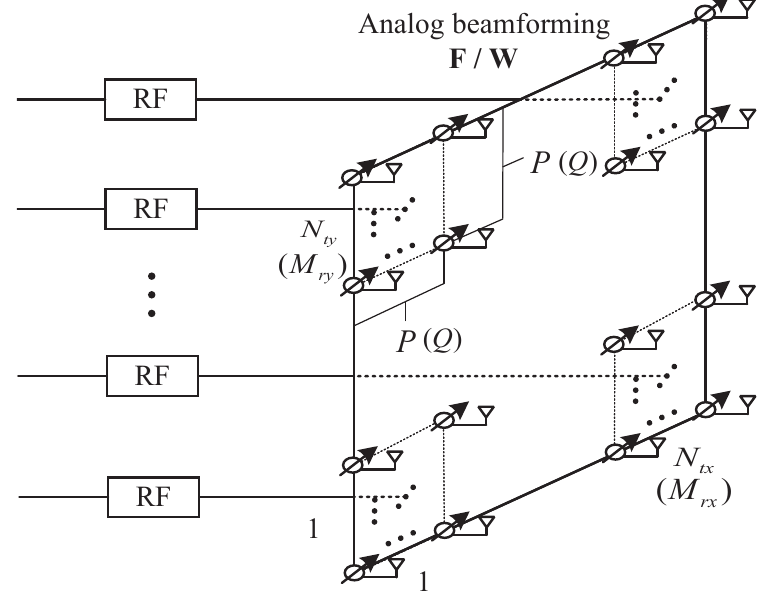
Figure 1. The hybrid arrays with planar